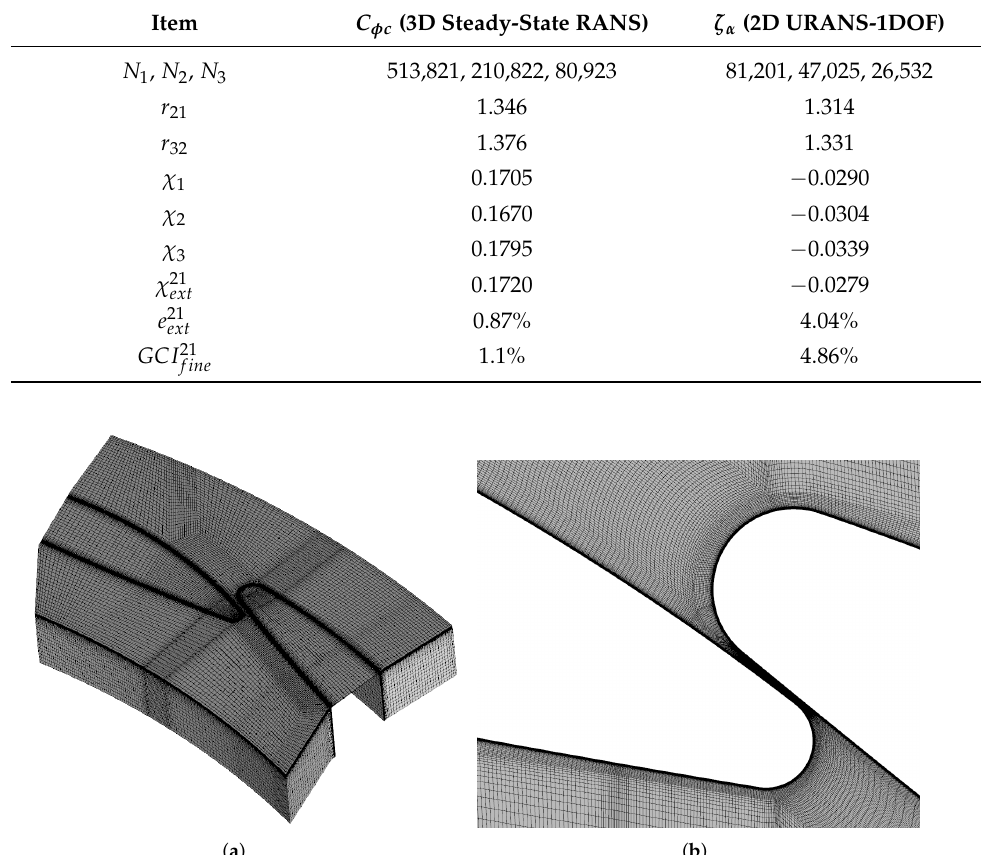
Table 2. The calculations of the discretization error of the mesh.